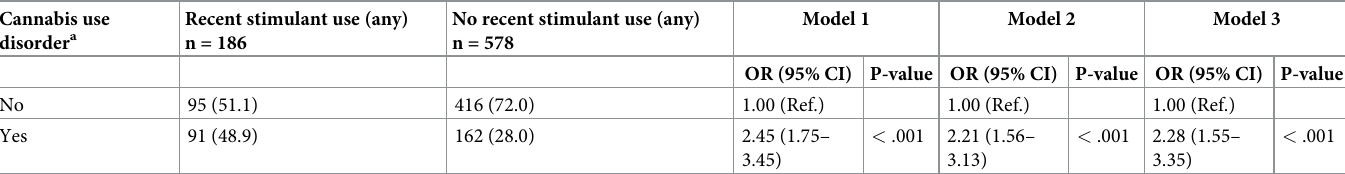
Table 4. Odds ratios for the association between having a cannabis use disorder and recent stimulant use. Recent stimulant use (any) Cannabis use n = disorder a